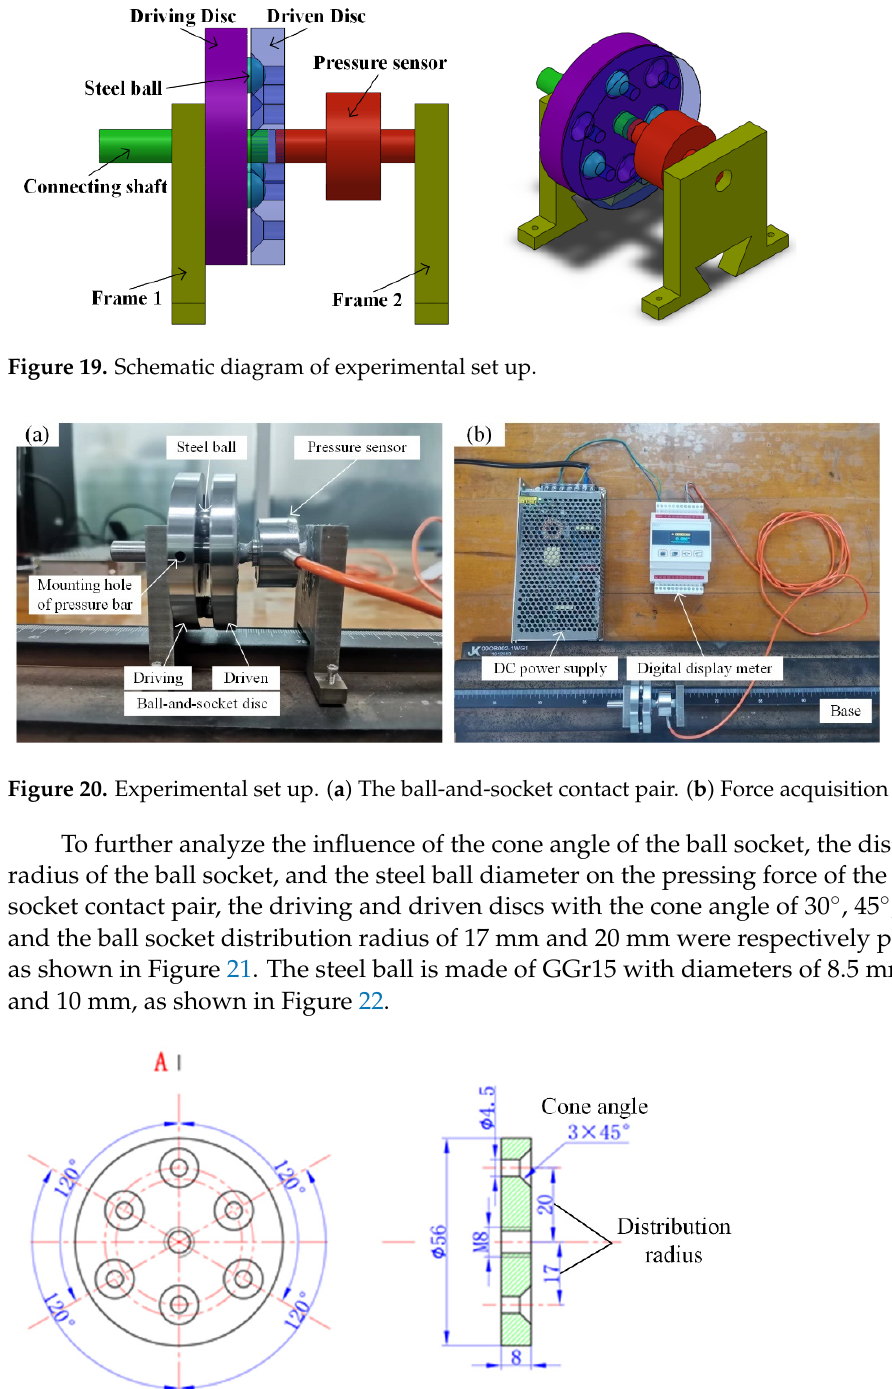
( b ) Figure 18. Dynamic features of output shaft under continuous closing. ( a ) Angular velocity. ( b ) An ‐ gular displacement. 5. Verification of Actuating Principle of Ball ‐ and ‐ Socket Contact Pair 5.1. Experimental Procedures To verify the actuating principle of the torque ‐ pressure conversion in the non ‐ return device and the accuracy of the SIMULINK model, the schematic diagram and experimental set ‐ up of the ball ‐ and ‐ socket contact pair are highlighted in Figures 19 and 20, respectively. The pressure sensor is fixedly connected with frame 2 and the driven disc through the thread. The connecting shaft is fixedly connected with frame 1. The driving disc is sleeved on the connecting shaft and can rotate and slide freely. The steel ball is installed in the ball ‐ and ‐ socket contact pair formed between the driving disc and the